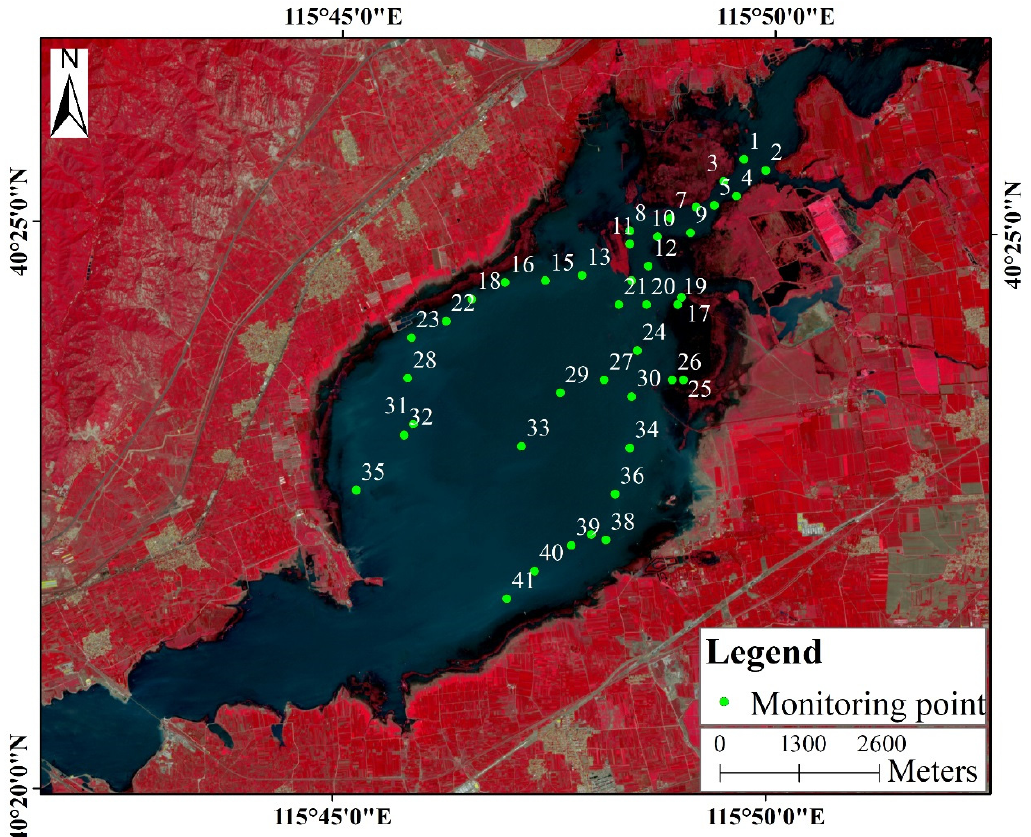
Figure 2. The locations for 41 sampling points are depicted with green circles and numbered 1 to 41 at Guanting Reservoir in 2017. The bottom picture is the standard false color display of the Sentinel-2A image. The sampling points were mainly concentrated in the reservoir area within Beijing, China. The sampling path is along the edge or near the center line of the area. Table 2. Description of the selected sample points. Effective sampling points refer to the number of abnormal points removed.